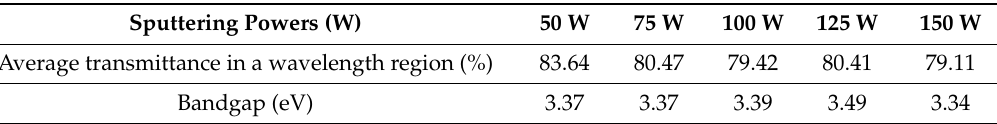
Table 3. IZTO film with different sputtering powers based on average transmittance in a wavelength region of 400 nm–800 nm and the associated band gaps.